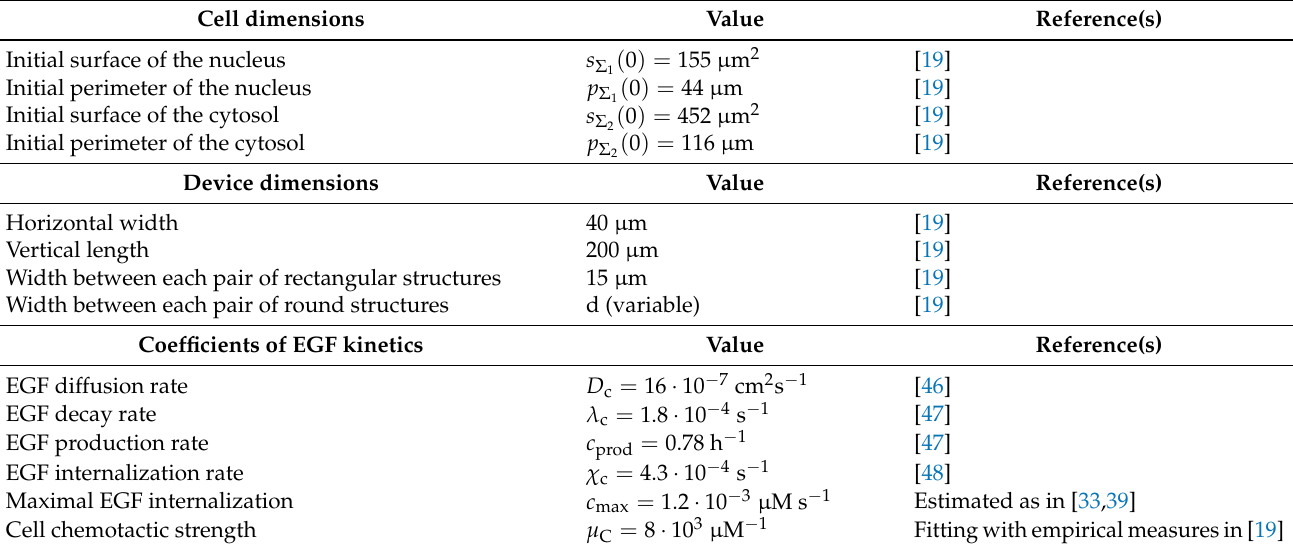
Table 2. Values of the model parameters whose estimates relate to the experimental system proposed in [19]. They belong to the set P 1 defined in Equation (11).